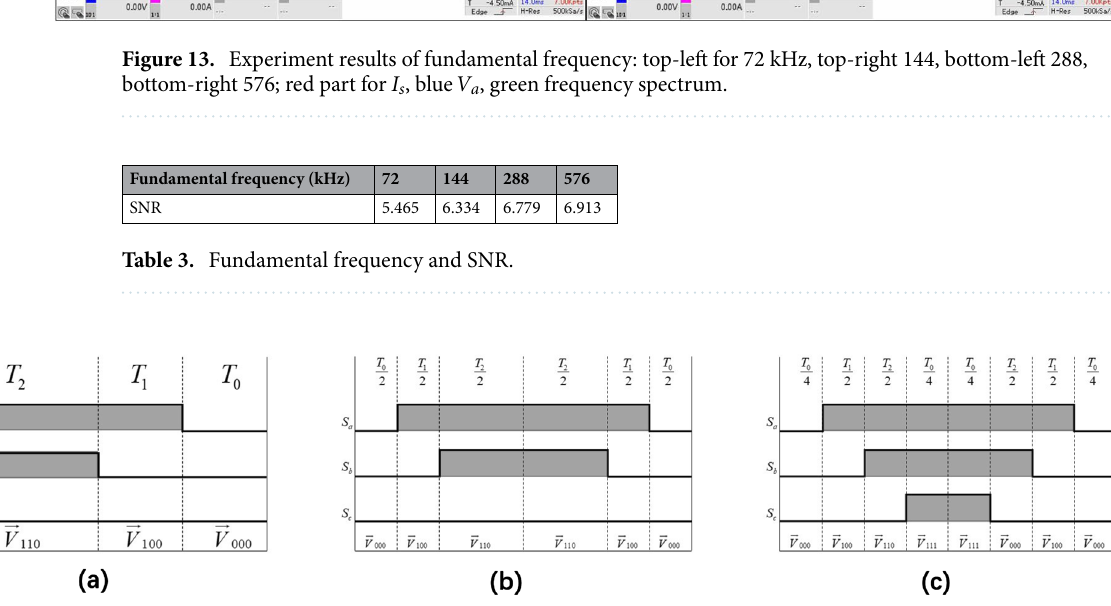
Figure 14. ( a ) stands for asymmetric wave, ( b ) five-segment symmetrical, ( c ) seven-segment